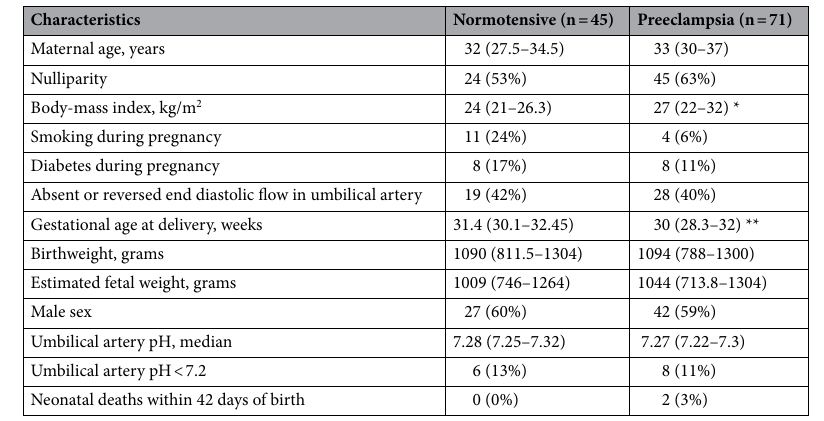
Table 1. Patient characteristics of pregnancies complicated with fetal growth restriction with and without preeclampsia. Data are n (%),or median (IQR). Missing BMI data for n = 3 normotensive samples and n = 6 preeclamptic samples, and umbilical artery pH for n = 1 preeclamptic sample. Estimated fetal weight not available for n = 4 normotensive and n = 5 preeclamptic samples. * p < 0.05, ** p <